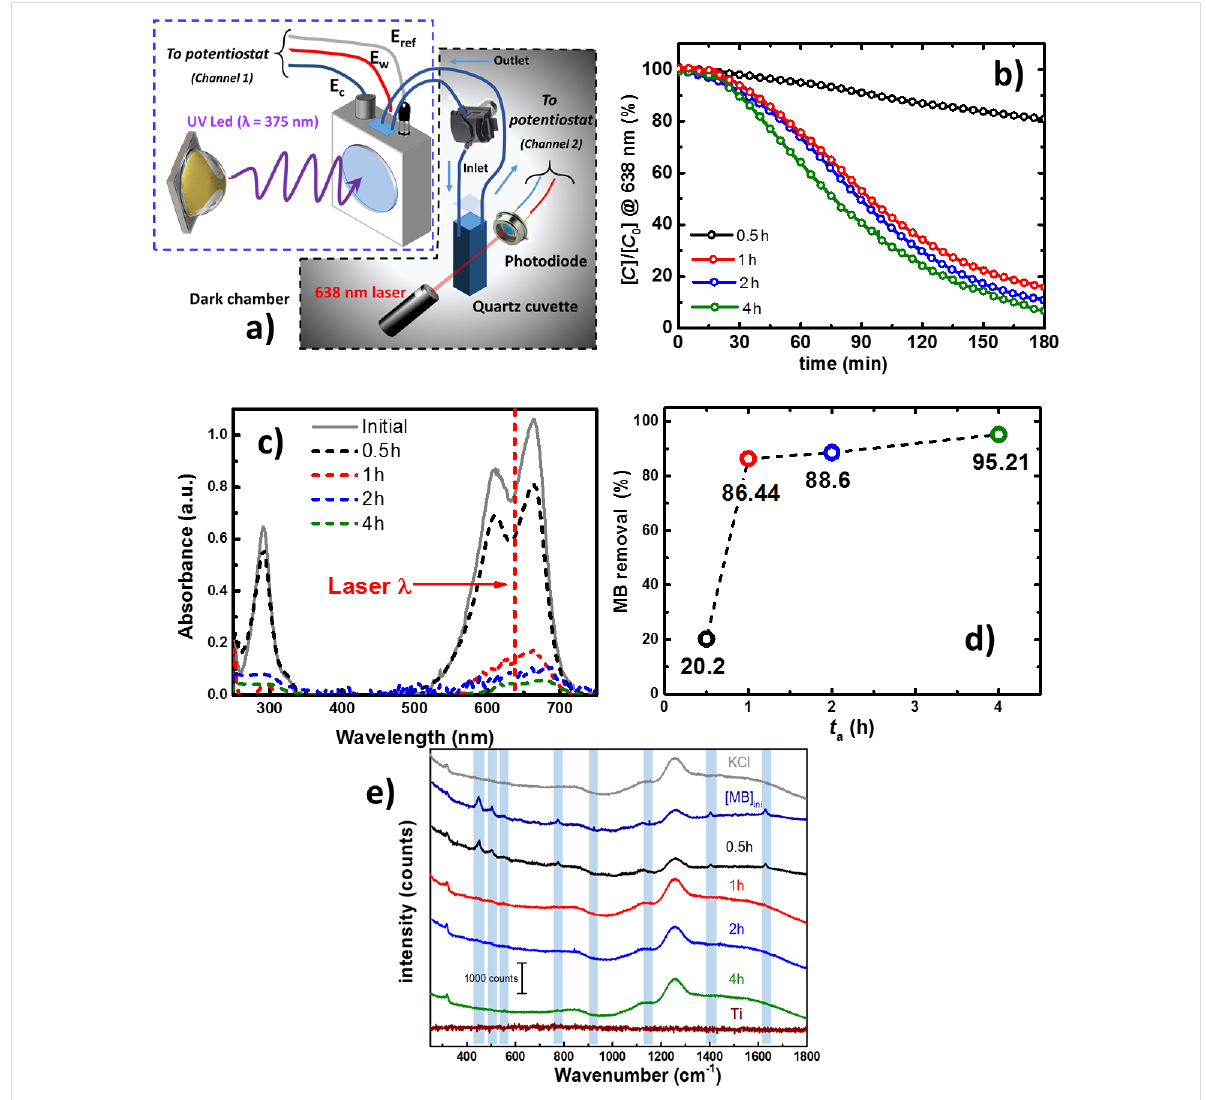
Figure 9: a) Schematics of the experimental setup used for the PEC degradation of MB. b) UV–vis spectra for the initial MB solution and after 180 min of treatment. c) Relative MB concentration followed in situ with a 638 nm laser. d) Removal percentage of MB evaluated from the UV–vis spectra. e) Raman spectra of the solution samples after 180 min of treatment. Raman conditions: laser 785 nm, slit 100 μ